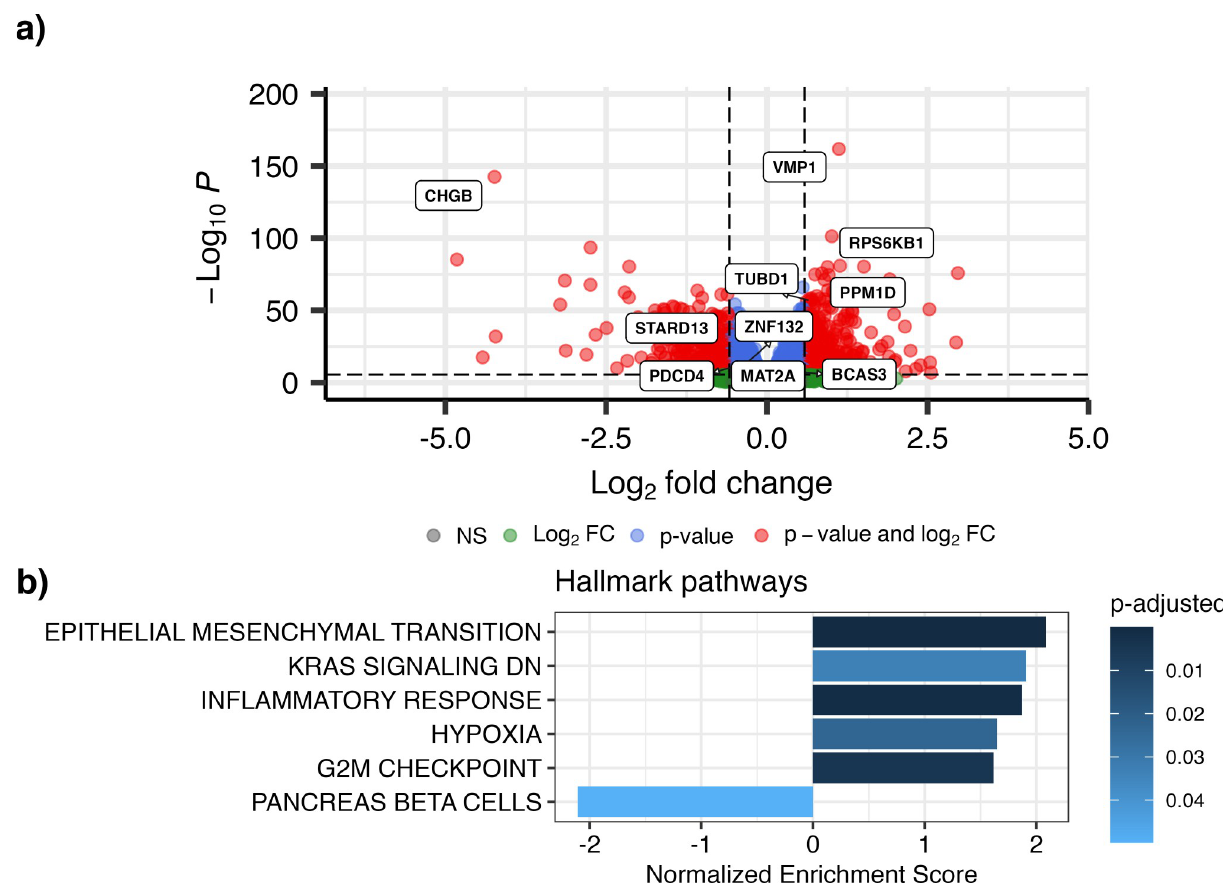
Fig 3. Meta-analysis of mRNA correlation with miR-21-3p. a) Volcano plot from TCGA and METABRIC meta-analysis, showing genes in red that had a significant p-value (FWER threshold) and at least 1.5 fold change in expression (|log 2 (FC)| > 0.585). Select genes relevant to this research are highlighted. b) Gene set enrichment analysis (GSEA) of the Hallmark pathways, obtained from the MSigDB collections, showed that genes in the meta- analysis that positively correlate with miR-21-3p expression (using 5% FWER as significance threshold from the meta-analysis while only including genes that were significantly correlated with miR-21-3p in both TCGA and METABRIC at 5% FDR) fall within pathways of EMT, proliferation and inflammation while genes that negatively correlate with miR-21-3p are in the pancreas beta cells pathway.